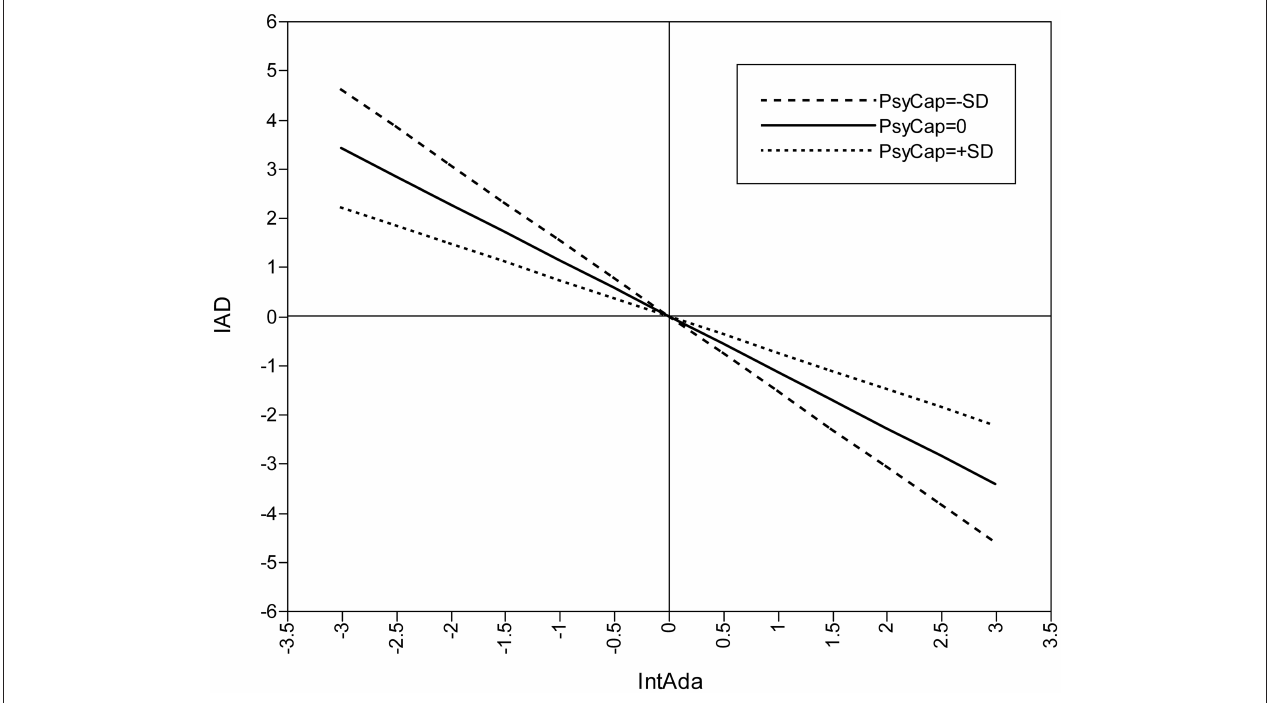
FIGURE 4 | Moderated effect of PsyCap on IntAda and